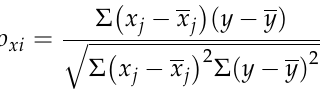
Figure 5. Four groups of HI change curve of CS2–35 battery. ( a ) I peak value; ( b ) I peak position; ( c ) II peak value; ( d ) II peak